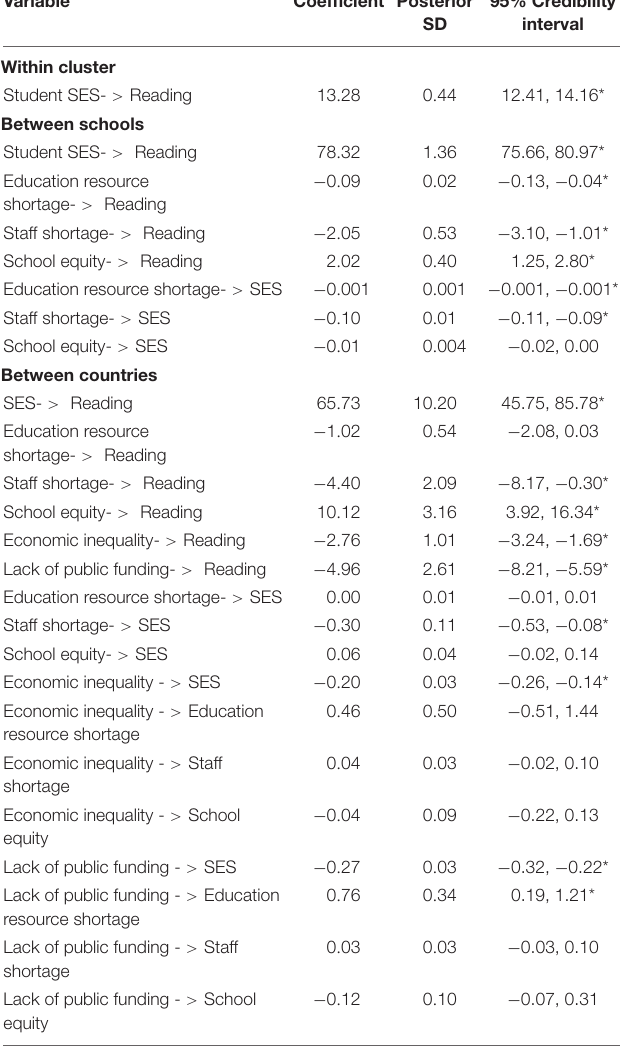
TABLE 7 | Fixed direct effects parameter estimates for partial mediation model: Reading.